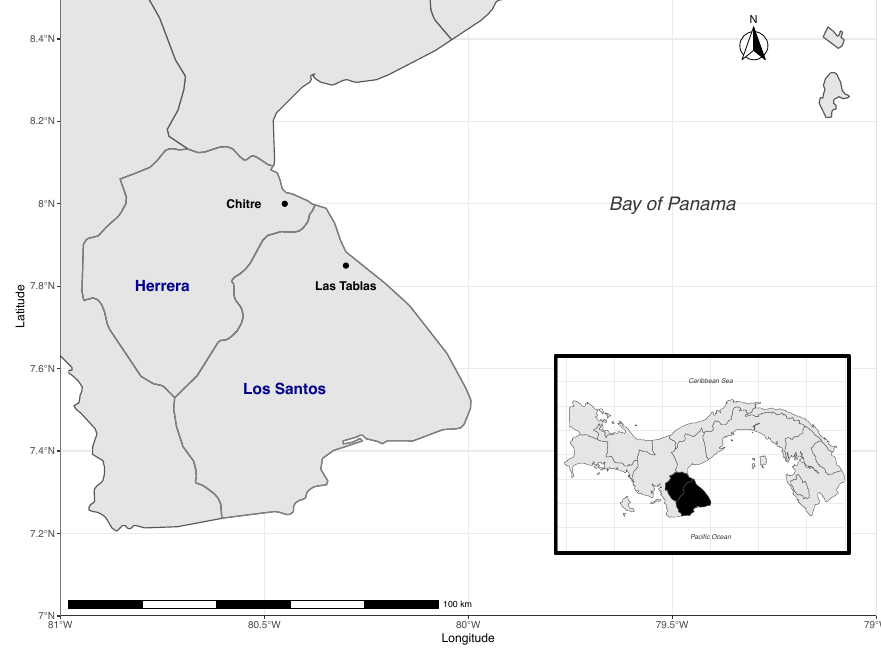
Figure 1. Location of the Azuero Region of Panama. Source: The